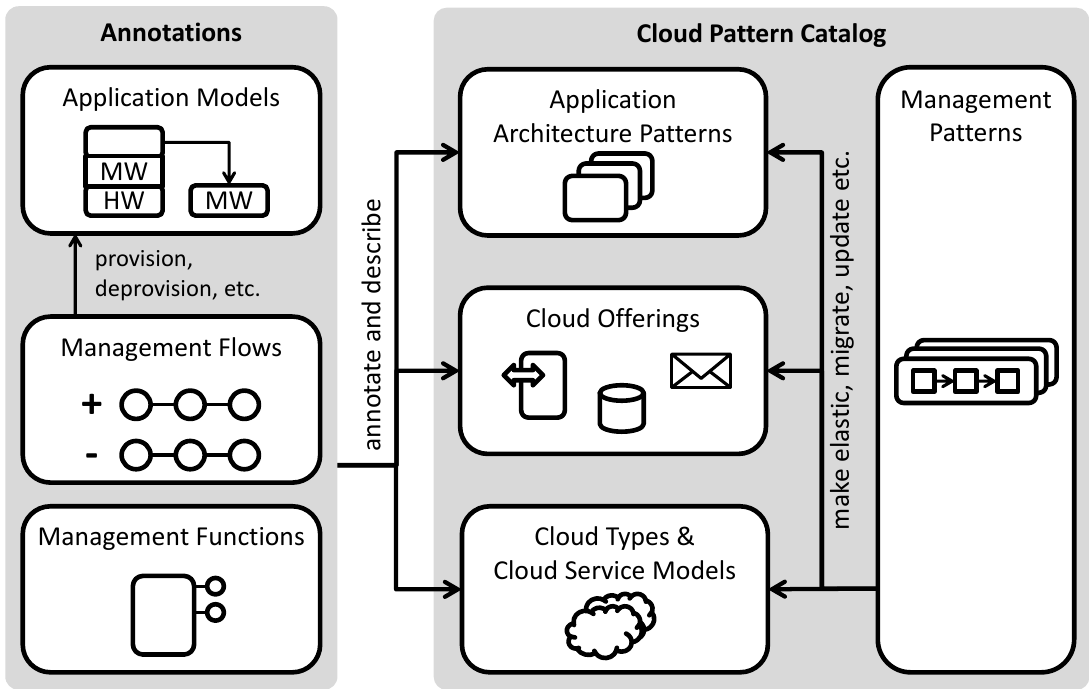
Figure 15. Organization of Cloud Patterns in the Catalog and Annotated Implementation